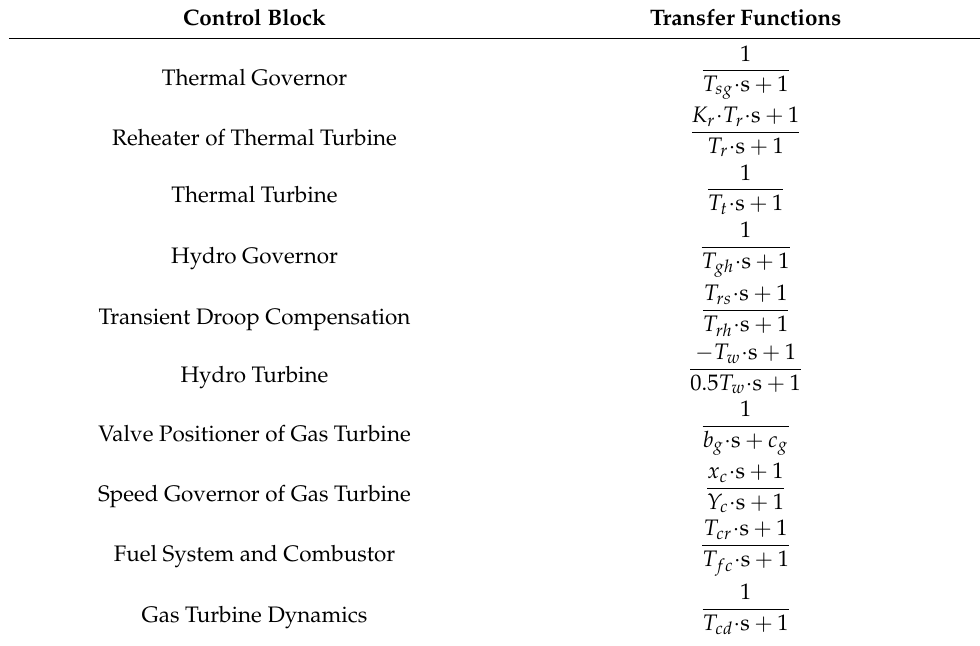
Figure 2. The transfer function model of the studied power grid. Table 2. The transfer functions that are presented in the studied power